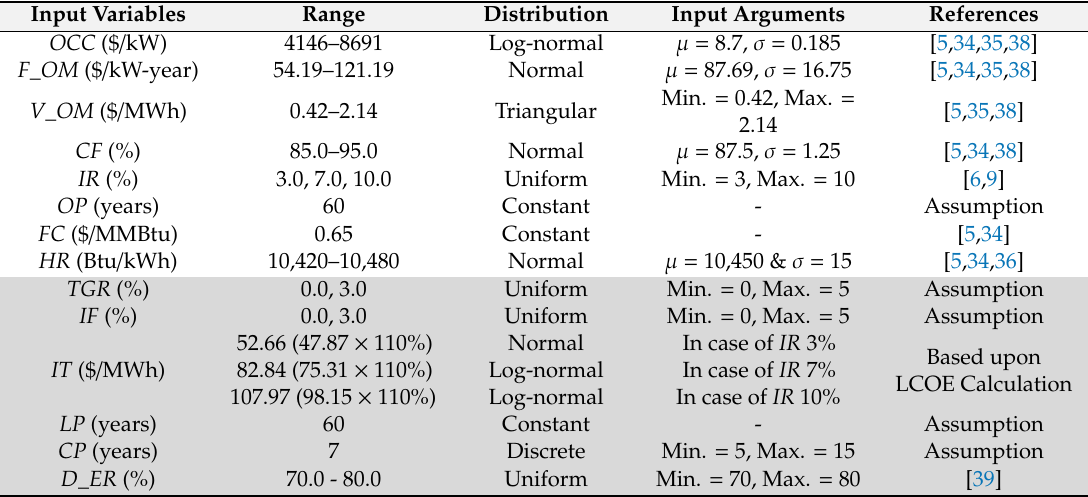
Table 3. Nuclear Input